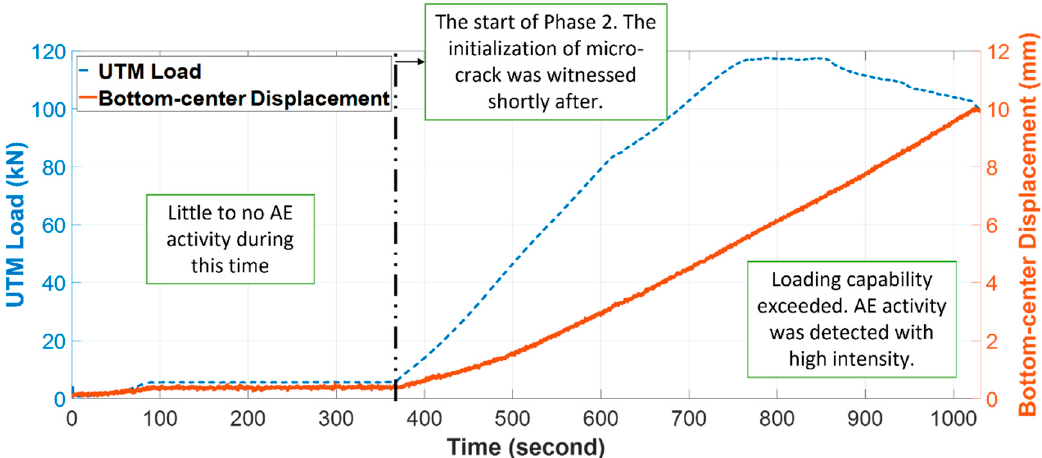
Figure 2. Loading versus the bottom displacement during the two testing